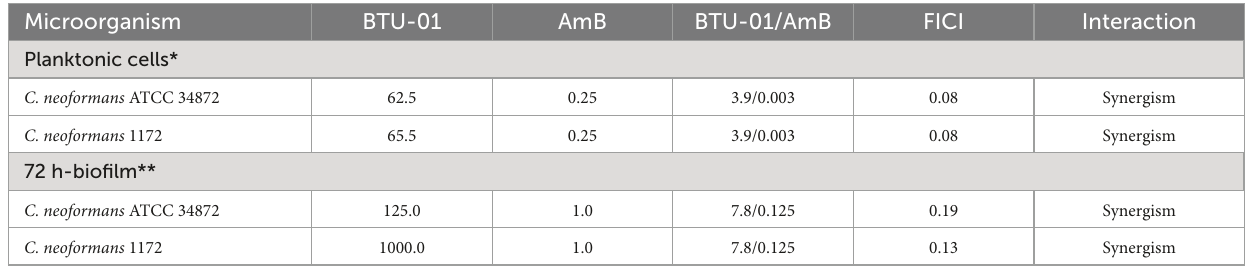
TABLE 2 Antifungal effect of N -(butylcarbamothioyl) benzamide (BTU-01) combined with amphotericin B (AmB) against planktonic cells and biofilms of Cryptococcus neoformans .